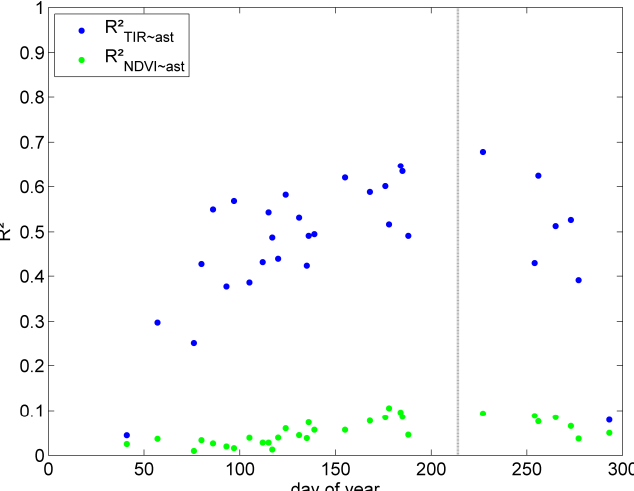
Figure 4. Variance in ASTER LST data (day indicated by dotted line) that can be explained by Landsat data (TIR and NDVI) from different